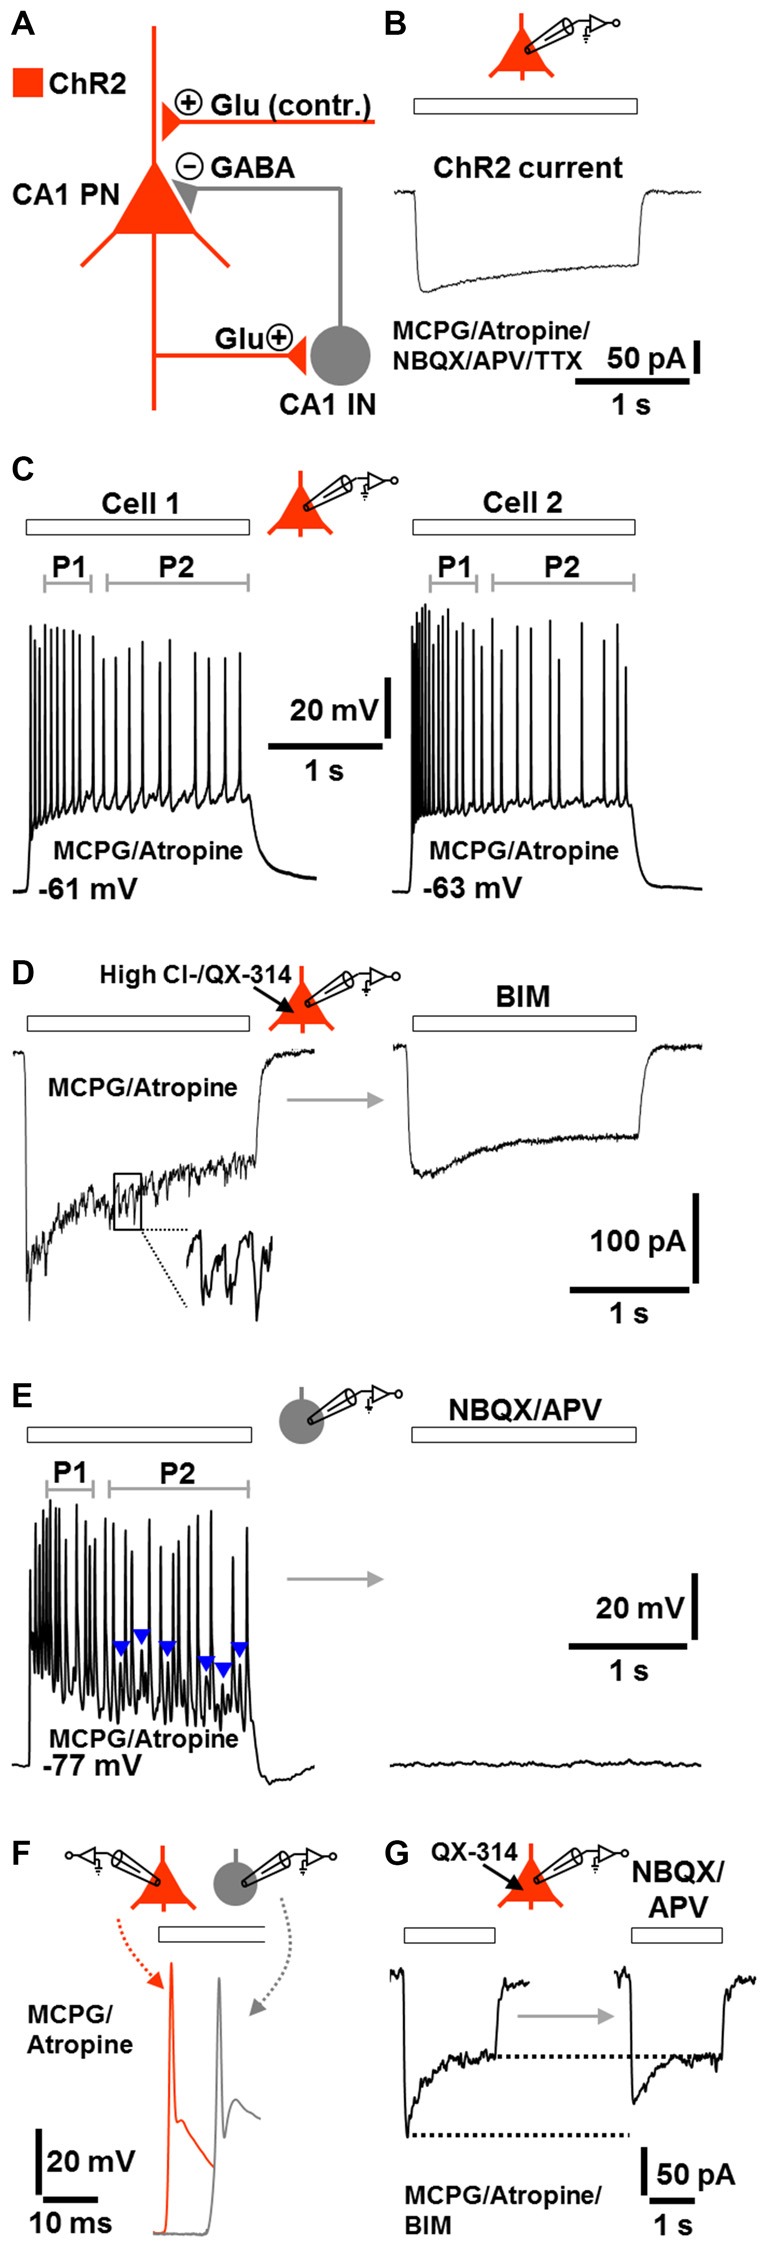
Model of the network components and signaling modalities underlying or contributing (contr.) to the optogenetically induced fast CA1 oscillations under group I/II mGlu/mACh receptor blockade (A) and corroborative single-cell activities during ChR2 activation (B–G; Glu, glutamate). All recordings were performed in the continuous presence of MCPG and atropine. If not stated otherwise, recordings were made using a K-gluconate-based intracellular solution. Halogen light intensity was always 12 mW/mm2. Holding potential in voltage-clamp measurements was −70 mV. Application time of drug(s) in (D,E,G) was 10 min. (B) ChR2 current in a CA1 PN evoked by halogen light illumination (extracellular solution additionally contained NBQX, APV, and TTX). (C) CA1 PNs immediately fired action potentials in response to halogen light illumination and continued spiking until the end of light application. The frequency of action potentials in P2 was lower than in P1. Representative recording traces from two cells are shown. (D) Fast postsynaptic inward currents in a CA1 PN during halogen light delivery. These currents could be unmasked by recordings with a high Cl− intracellular solution containing the sodium channel blocker QX-314. The currents promptly subsided when light delivery was terminated and were completely blocked by the GABAA receptor antagonist BIM. (E) Whole-cell patch-clamp recording from a CA1 stratum oriens IN. Although lacking ChR2, the neuron continuously fired during halogen light application and spike trains were interspersed with prominent excitatory postsynaptic potentials (EPSPs; blue arrow heads). As observed for CA1 PNs, the frequency of action potentials in P2 was lower than in P1. The cell was totally silenced by ionotropic glutamate receptor blockade by NBQX and APV. (F) Illustration of the time delay (~10 ms) between the first action potential in CA1 INs and the first action potential in CA1 PNs. Representative recording traces from separate measurements are shown. (G) Light-evoked inward currents in a CA1 PN (in the presence of BIM) before and after addition of NBQX and APV to the extracellular solution (intracellular solution contained QX-314). Representative recording traces are depicted.